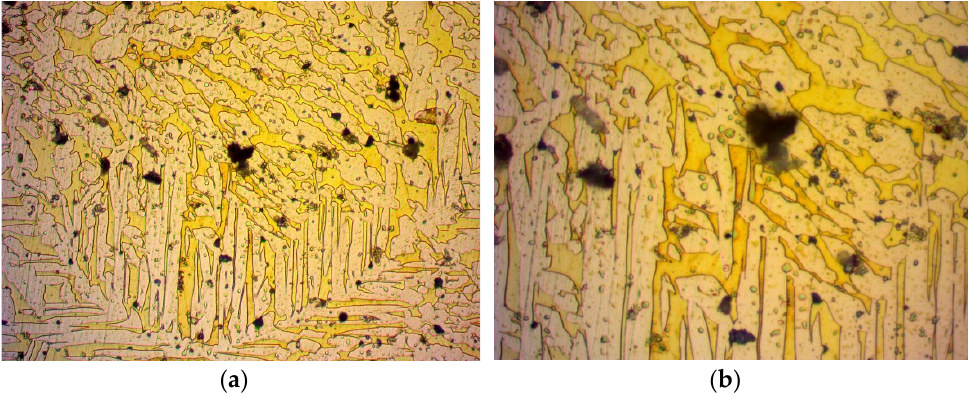
Figure 7. Specimen 5: Image from optical microscope after metallography of air stream quenched heated at 850 °C brass alloy: ( a ) magnification ×500; ( b ) magnification ×1000.